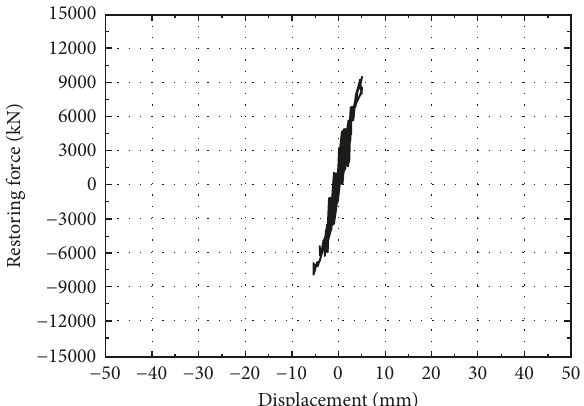
Figure 21: Hysteresis curve of intensity 7 frequently of synthesized (transverse